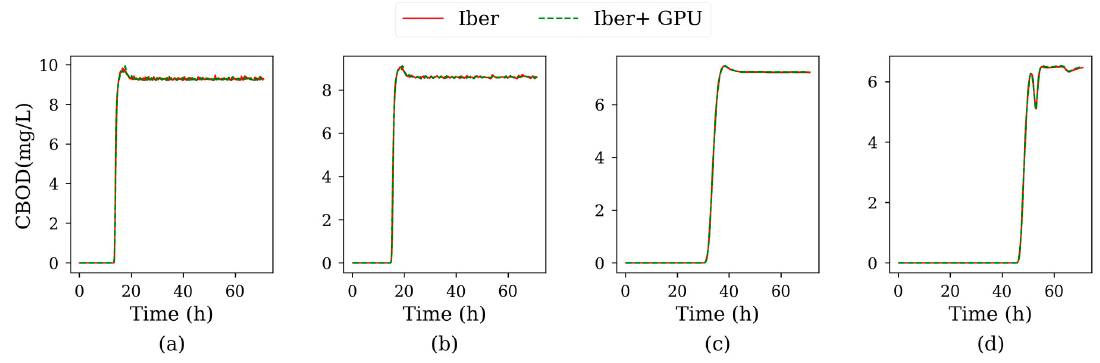
Figure A14. Time series of CBOD for Test 4, sampled at control points P1 ( a ), P2 ( b ), P3 ( c ) and P4 ( d ).